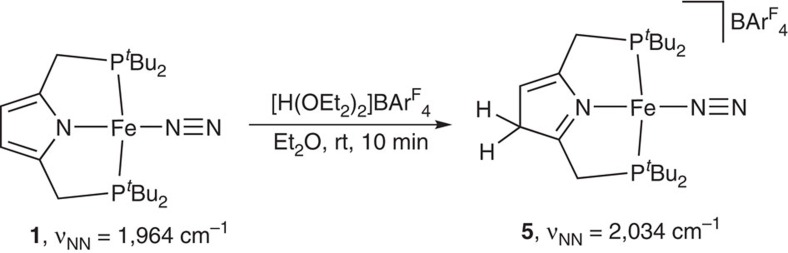
Reactivity of iron-dinitrogen complex 1.Protonation of 1 with [H(OEt2)2]BArF4 occurred at the pyrrole ring to give 5.